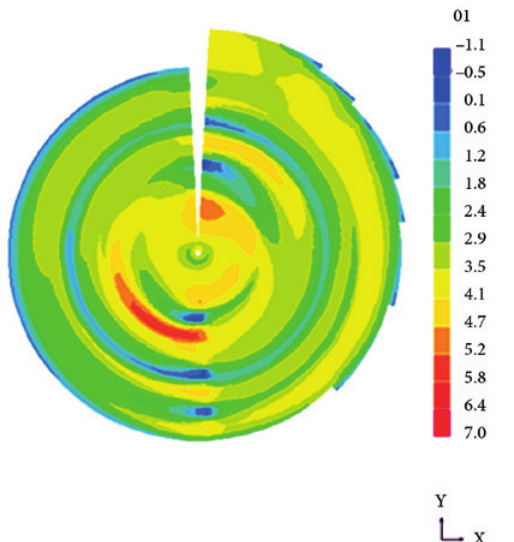
Fig. 4. Single-phase flow rate in multi-channel cyclone, where the distance z from the top of the separation chamber of cyclone is z = 0.05